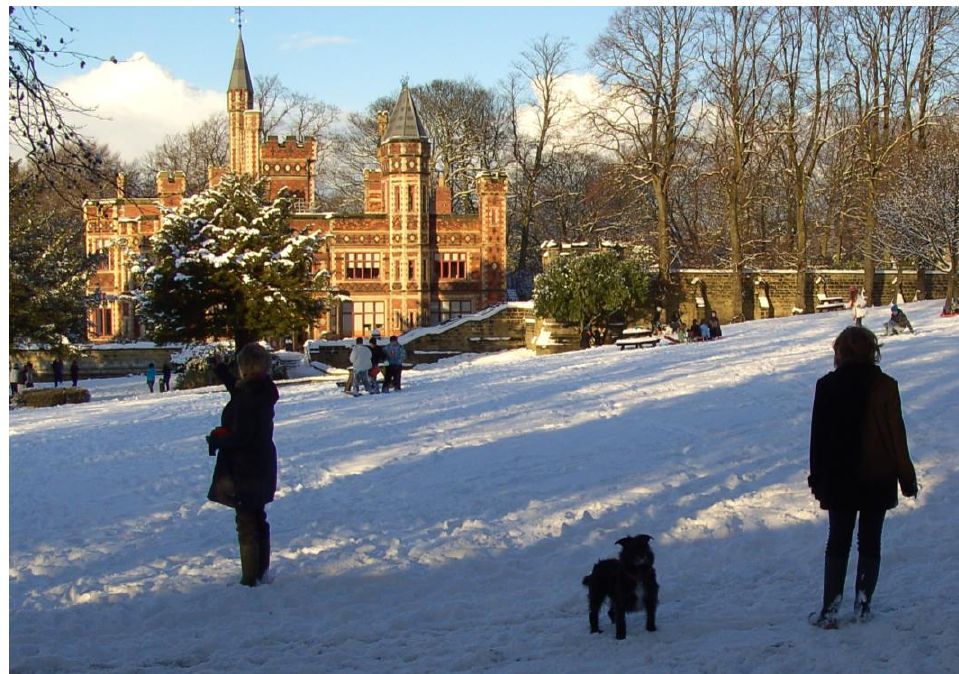
Figure 6. The Towers.